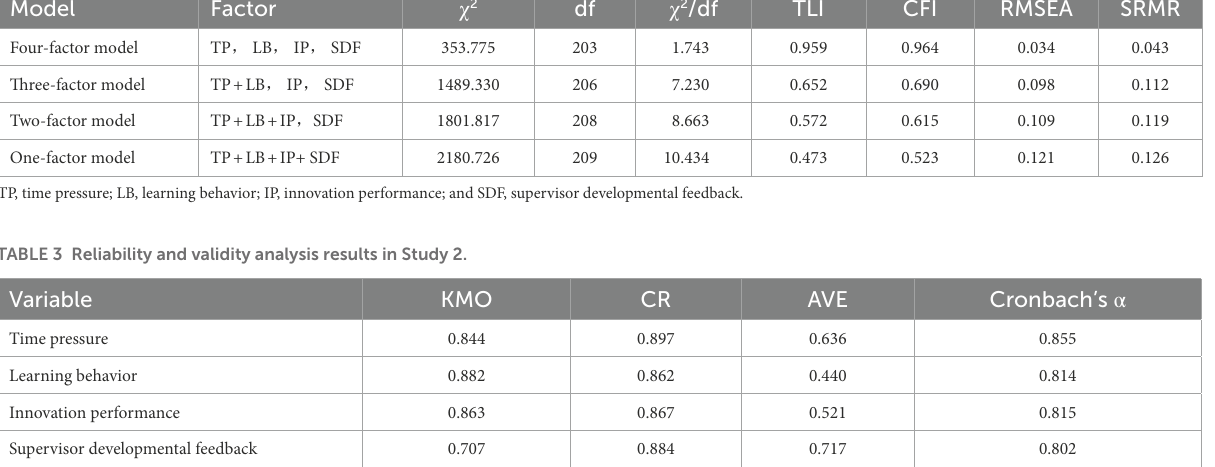
TABLE 2 Results of confirmatory factor analysis in Study 2.